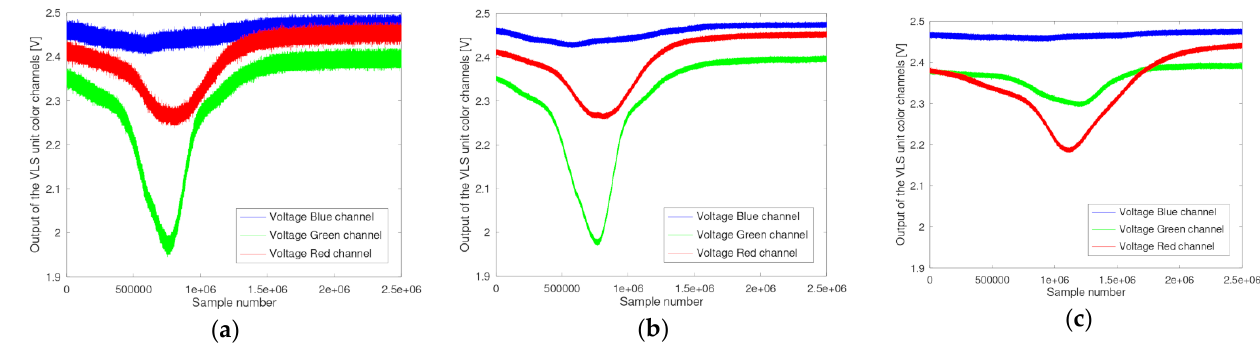
Figure 5. ( a ) Single run of scenario “O yellow Area 4 Speed 4” ( b ) computed reference curve of scenario “O yellow Area 4 Speed 4” after 10 runs ( c ) computed reference curve (10 runs) of scenario “3M red Area 4 Speed1”.